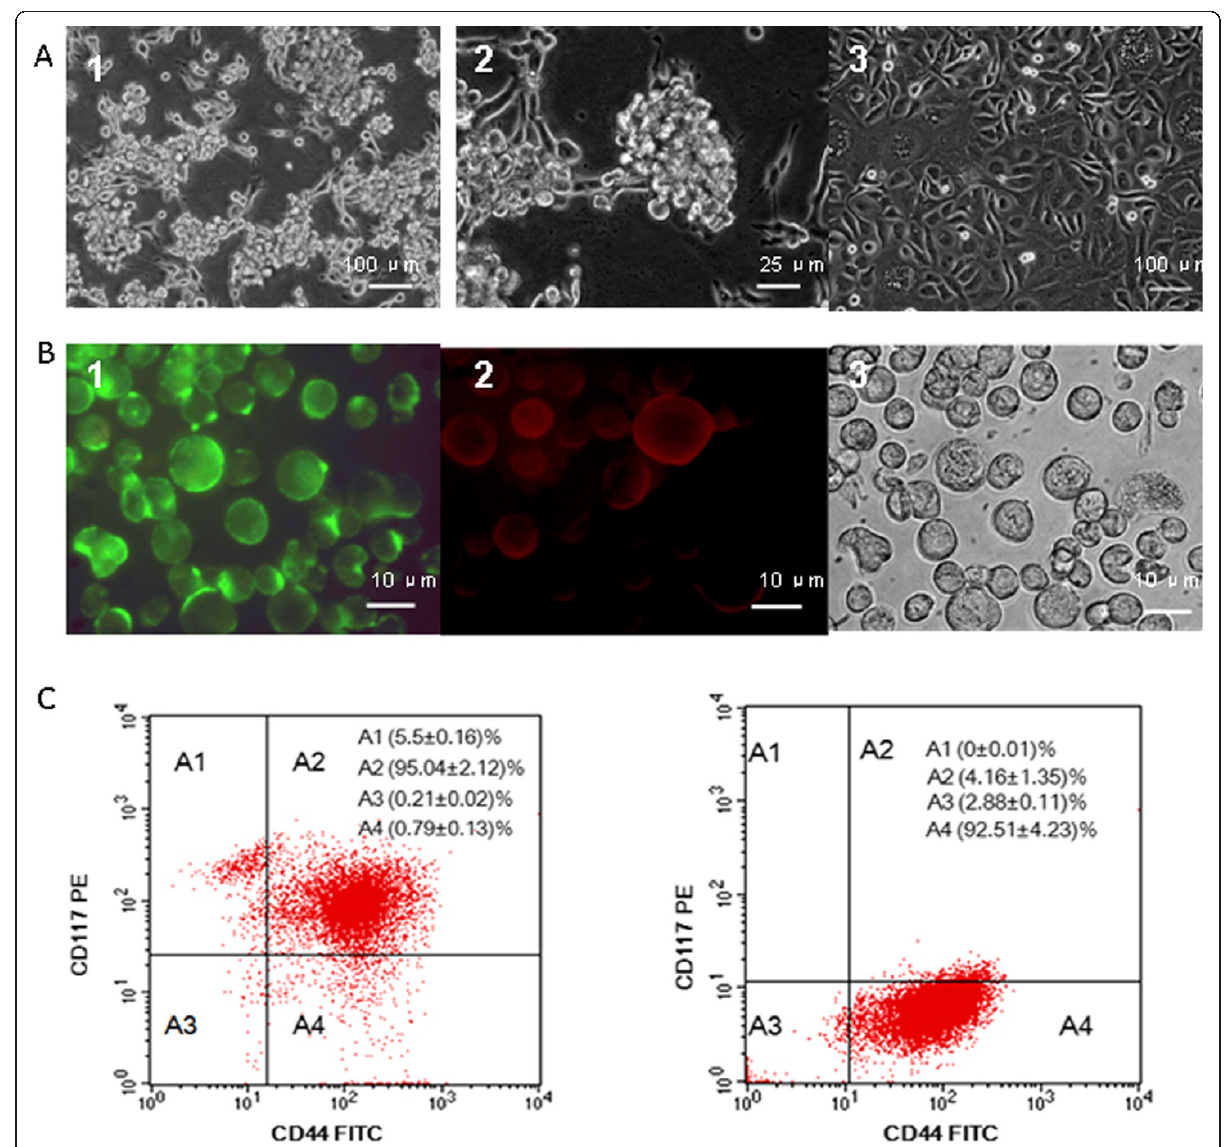
Figure 1 Observation and analysis of CD44 + CD117 + CSCs. The CD44 + CD117 + cells were sorted from the SKOV-3 cell line by MACS, and cultured in the stem cell culture medium on day 20 passage (A1, 100×, A2, 400×) or common 2D culture on day 10 passages (A3, 100×). B1 and B2 show the CD44 and CD117 positive cells detected by FCM. B3 displays the image of CD44 + CD117 + CSCs without staining with immunofluorescence (400×). Consistent with the result of immunofluorescence analysis, FCM analysis shows a high percentage of CD44 and CD117 molecules (95.04%) in the CD44 + CD117 + cells after being in the stem cell culture medium for 2 day (C Left); the percentage was only 4.16 for the SKOV-3 cells (C